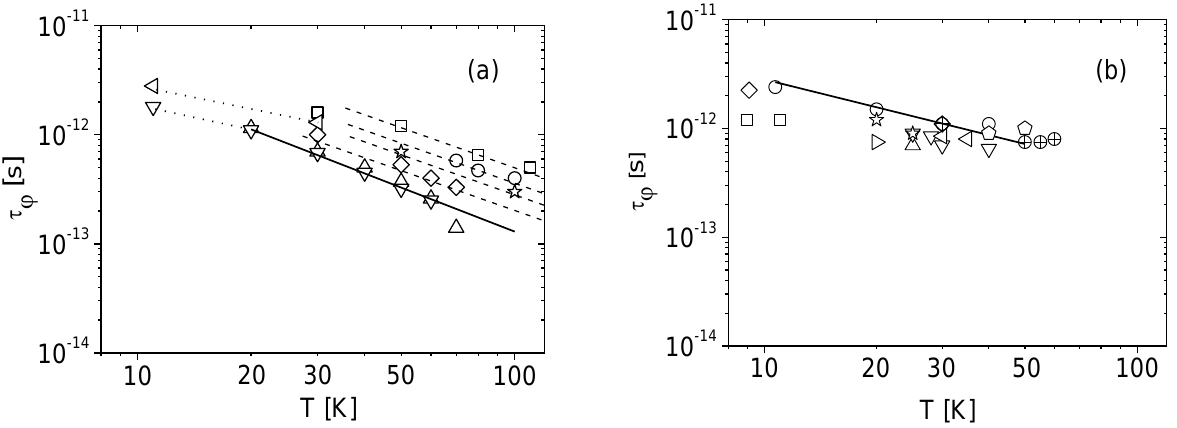
Figure 6. The phasing coherence time τ ϕ derived from the nMR data versus temperature for dif- Figure 6. The phasing coherence time τ φ derived from the nMR data versus temperature for differ- Figure 6. The phasing coherence time τ φ derived from the nMR data versus temperature for different Figure 6. The phasing coherence time τ φ derived from the nMR data versus temperature for differ- Figure 6. The phasing coherence time τ φ derived from the nMR data versus temperature for differ- ent samples. ( a ): MOVPE samples:  M2;  M3;  M4; PAMBE samples:  P6;  P15; HVPE ferent samples. ( a ): MOVPE samples: ∇ M2; ∆ M3; ♦ M4; PAMBE samples: (cid:73) P6; P15; HVPE samples. ( a ): MOVPE samples: ∇ M2; Δ M3;  M4; PAMBE samples: ∗ P6; Ο P15; HVPE samples: ◁ ent samples. ( a ): MOVPE samples:  M2;  M3;  M4; PAMBE samples:  P6;  P15; HVPE ent samples. ( a ): MOVPE samples:  M2;  M3;  M4; PAMBE samples:  P6;  P15; HVPE samples:  H1;  H3; The data points are given with dashed and dot parallel lines as a guide to the samples: ∆ H1; (cid:3) H3; The data points are given with dashed and dot parallel lines as a guide to H1;  H3; The data points are given with dashed and dot parallel lines as a guide to the eye. Solid samples:  H1;  H3; The data points are given with dashed and dot parallel lines as a guide to the samples:  H1;  H3; The data points are given with dashed and dot parallel lines as a guide to the eye. Solid line, fitting for  and  samples: τ φ ( T ) = 6.2 × 10 −11 × T −1.34 (s). ( b ): Am samples:  A1;  the eye. Solid line, fitting for ∇ and ∆ samples: τ ϕ ( T ) = 6.2 × 10 − 11 × T − 1.34 (s). ( b ): Am samples: line, fitting for ∇ and Δ samples: τ φ ( T ) = 6.2 × 10 − 11 × T − 1.34 (s). ( b ): Am samples: Ο A1;  A2;  A4; Δ eye. Solid line, fitting for  and  samples: τ φ ( T ) = 6.2 × 10 −11 × T −1.34 (s). ( b ): Am samples:  A1;  eye. Solid line, fitting for  and  samples: τ φ ( T ) = 6.2 × 10 −11 × T −1.34 (s). ( b ): Am samples:  A1;  A2;  A4;  A5;  A6; ◁ A7;  A8; MFS samples:  F1;  F2;  F3;  F4; Solid line: τ φ ( T ) = 2 × A5; ∇ A6; ◁ A7; > A8; MFS samples: F1; F2; ⊕ F3;  F4; Solid line: τ φ ( T ) = 2 × 10 − 11 × T − 0.85 (s). A2;  A4;  A5;  A6; ◁ A7;  A8; MFS samples:  F1;  F2;  F3;  F4; Solid line: τ φ ( T ) = 2 × A2;  A4;  A5;  A6; ◁ A7;  A8; MFS samples:  F1;  F2;  F3;  F4; Solid line: τ φ ( T ) = 2 × 10 −11 × T −0.85 (s). 10 −11 × T −0.85 (s). 10 −11 × T −0.85